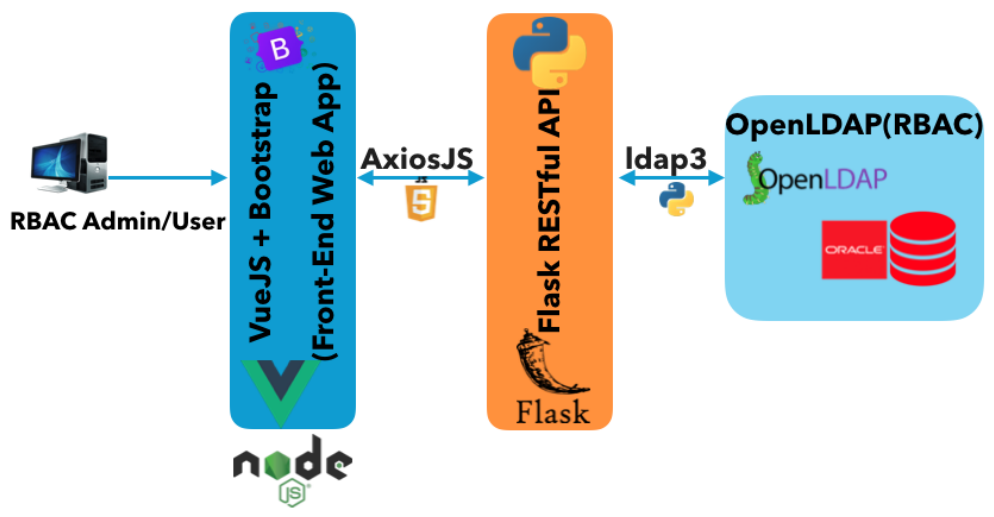
Figure 6. Centralized RBAC Architecture.